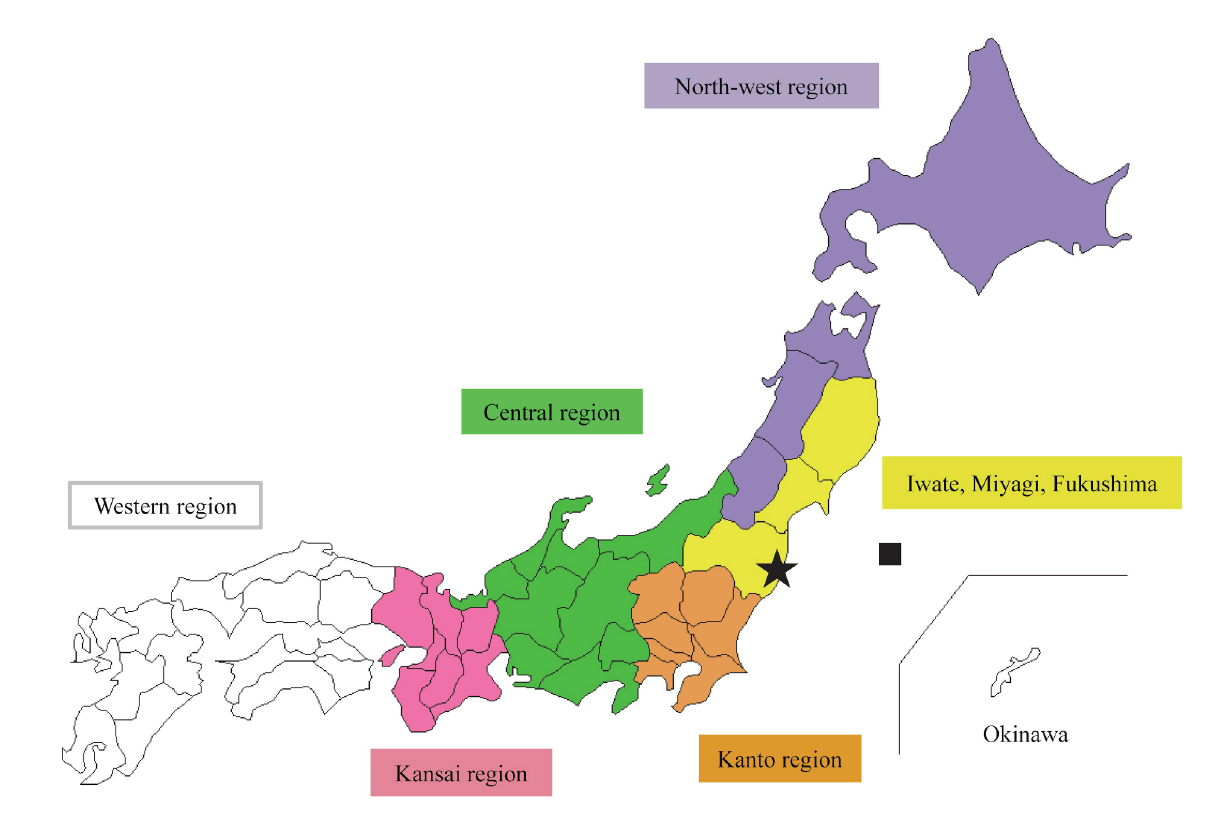
Figure 1. Map of Japan divided into six area indicators. The black square indicates the epicentre of the earthquake. The black star indicates the location of the Fukushima